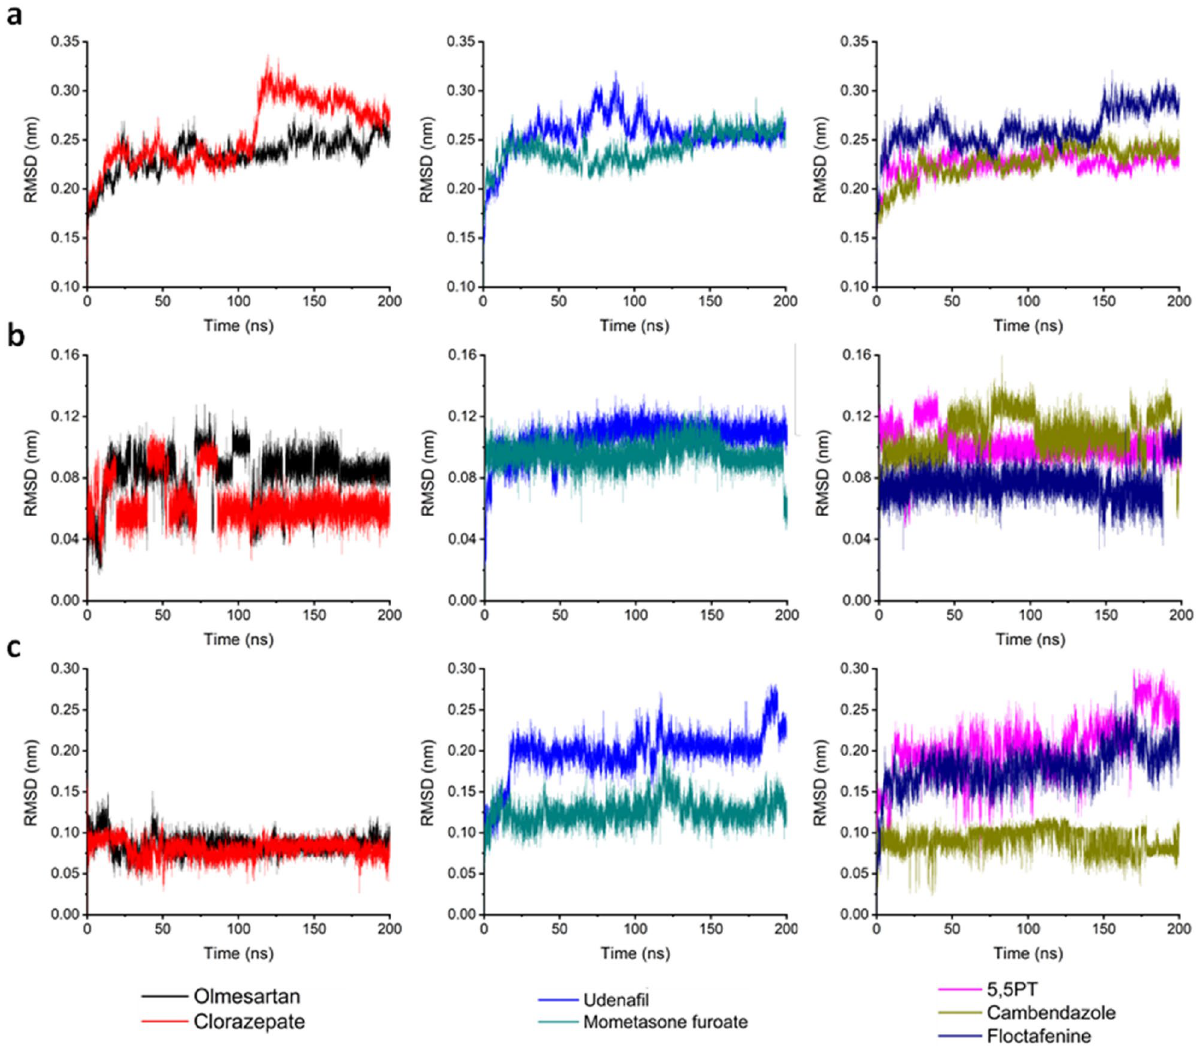
Figure 13. RMSD of GO ( a ), FCN ( b ), and the ligands ( c ) of the DB screening during the 200 ns